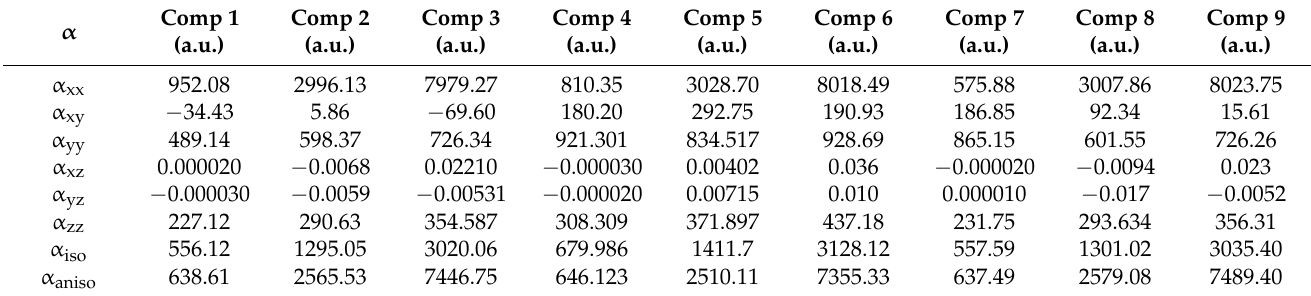
Table 1. Calculated α (a.u.) and the individual components.